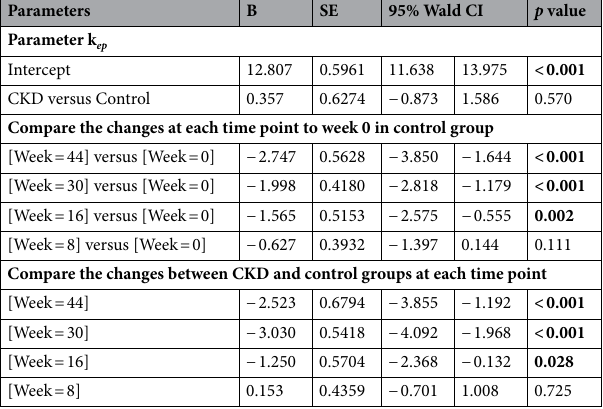
Table 3. Comparisons of perfusion parameter k ep between control and CKD groups over 44 weeks by GEE multiple linear regression. B: regression coefficient.